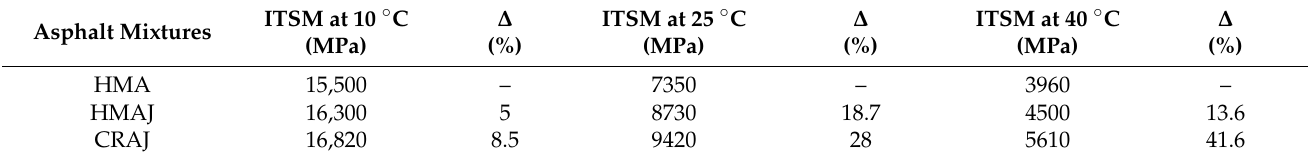
Table 7. ITSM values of HMA, HMAJ, and CRAJ, and variation ∆ of HMAJ and CRAJ in comparison with HMA. Asphalt Mixtures